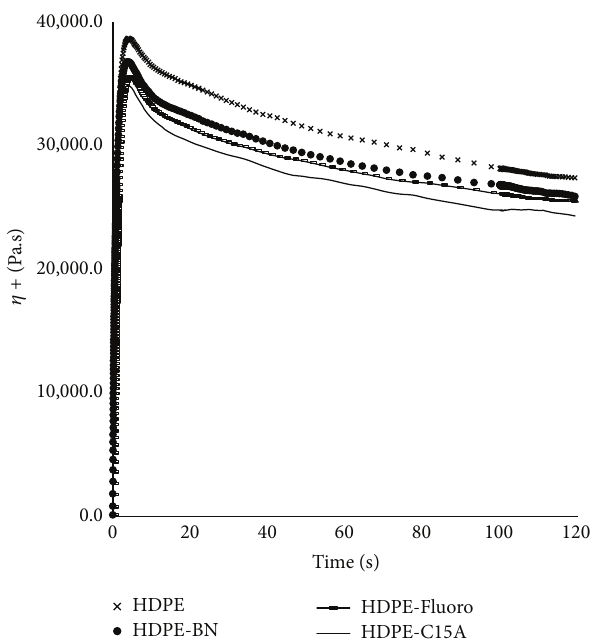
Figure 5: Transient shear growth test for HDPE, HDPE-C15A, HDPE-BN, and HDPE-Fluoro.